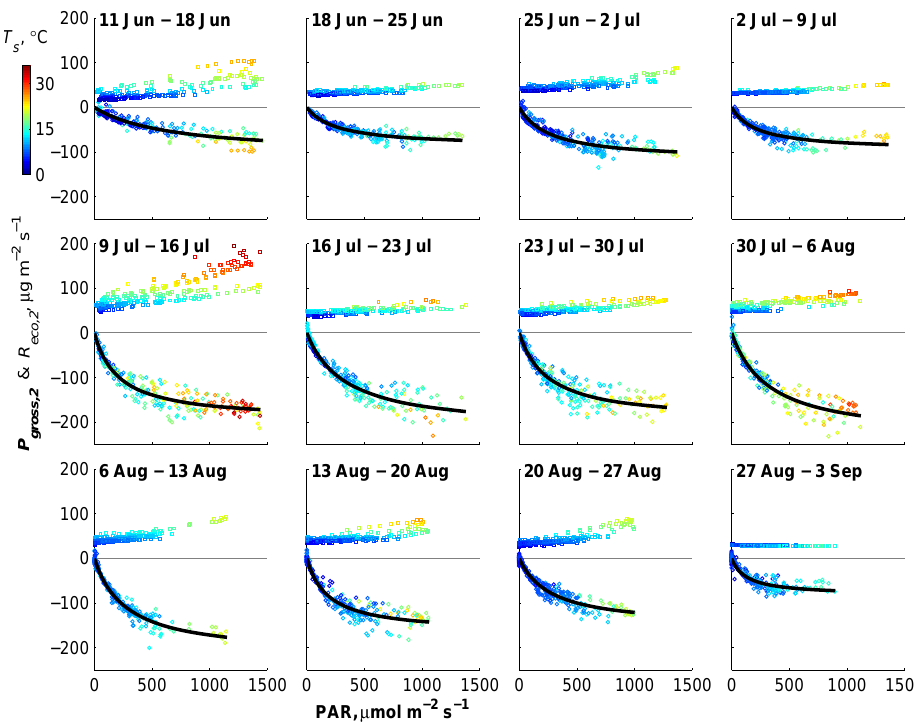
Fig. 4. Time series of scatter plots showing the NEE flux partitioned into modelled photosynthesis P gross , 2 and modelled ecosystem respi- ration R eco , 2 , plotted against PAR, with points colored according to surface temperature ( T s ) and generated according to the bulk method described in the text (i.e. Eqs. 3–4). The P gross , 2 model’s light-response parameters ( P max , 3 , α 3 ) are fit to each time slice by minimizing the root mean square of the residuals (rmse). P gross , 2 and R eco , 2 have units of µgm − 2 s − 1 . Each subplot represents a different one-week time period.